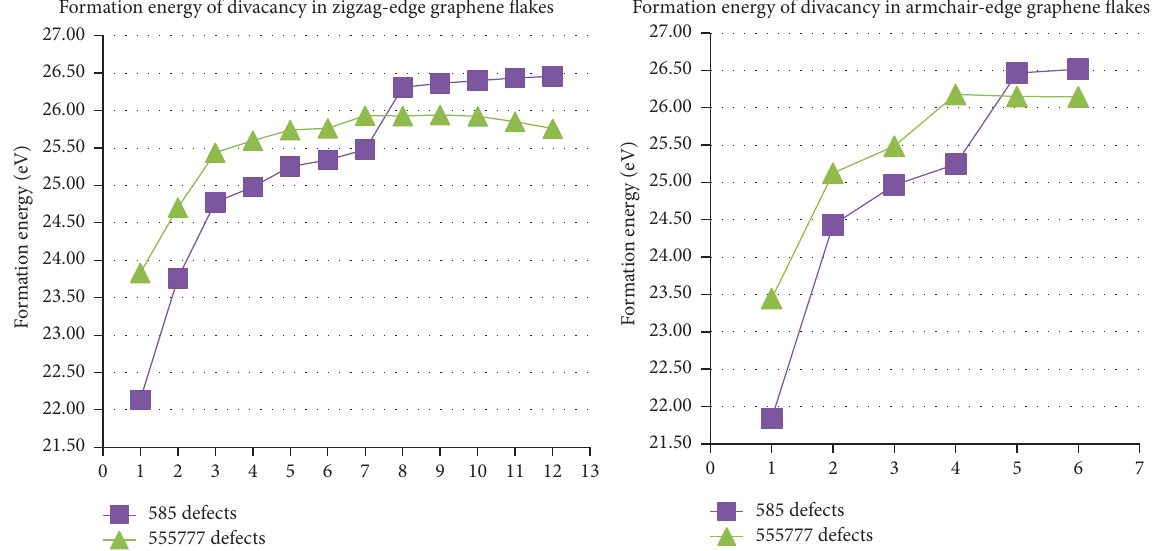
Figure 4: The formation energy of the two types of divacancy defects in zigzag- and armchair-edge HGFs by DFTB.